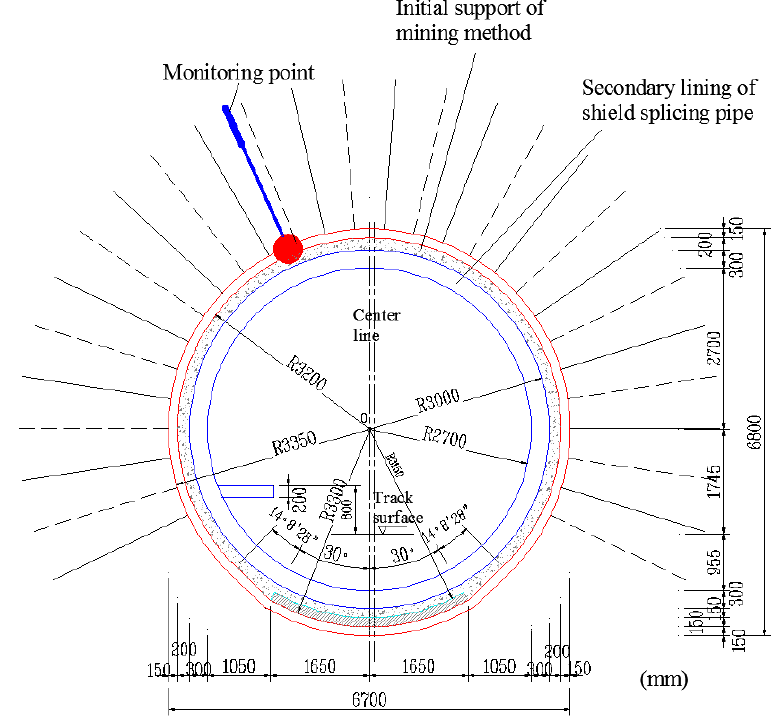
Figure 8. Transverse section showing the monitoring point.